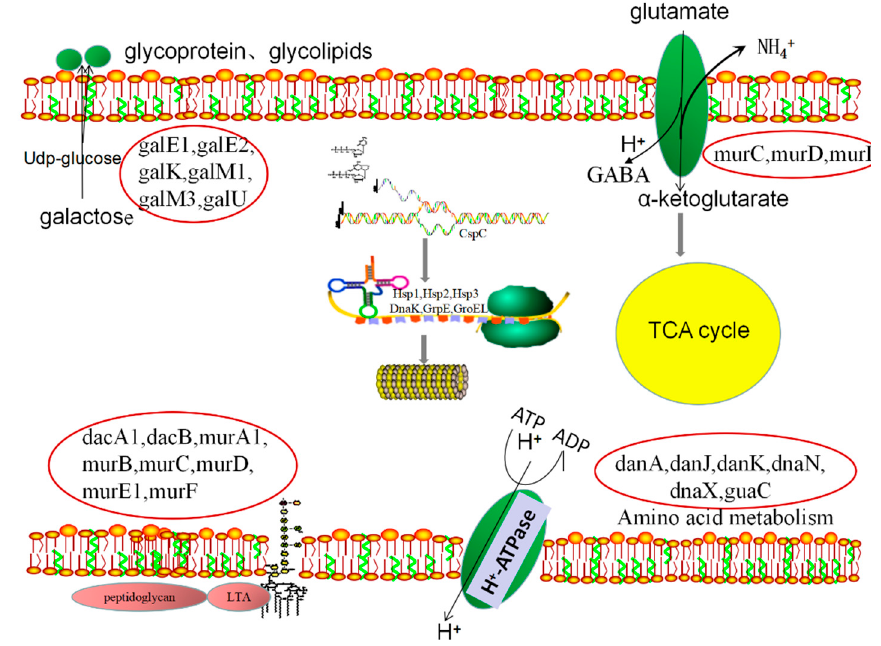
Figure 8. Proteomic pattern of Lpb. plantarum NMGL2 in response to combinational cold and acid stresses during cold storage of fermented milk.